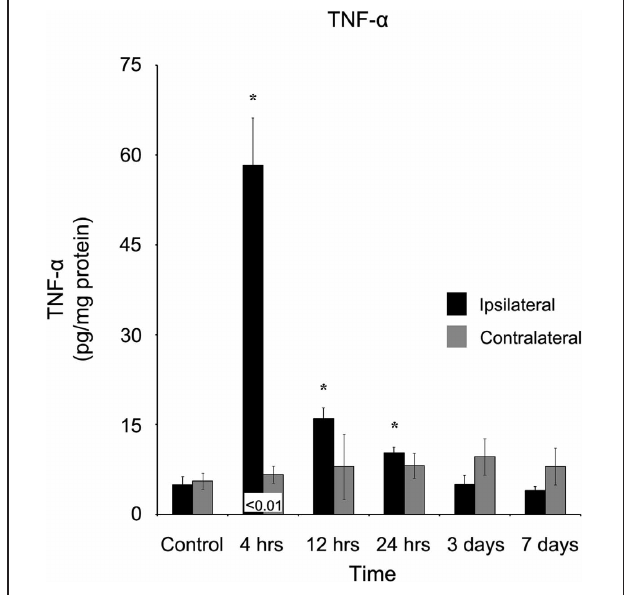
FIGURE 3 | TNF- α concentration increases in the ipsilateral cortex following a controlled cortical impact. Within four hours of a brain injury, TNF- α increases ( p < 0 . 05) in the ipsilateral cortex in comparison to both control and contralateral tissue. TNF- α remained elevated for the first 24 hours following injury, before returning to control levels at three days, post-injury. In contrast, the contralateral cortex did not demonstrate an increase in TNF- α expression at any time point in comparison to control. All values are mean ± SEM, n = 5. ∗ At each time point noted, ipsilateral differs from control tissue, p < 0 . 05. ± At each time point noted, contralateral differ from control tissue, p < 0 . 05. Differences between the ipsilateral and contralateral cortices are denoted by placing the appropriate p -value above the two